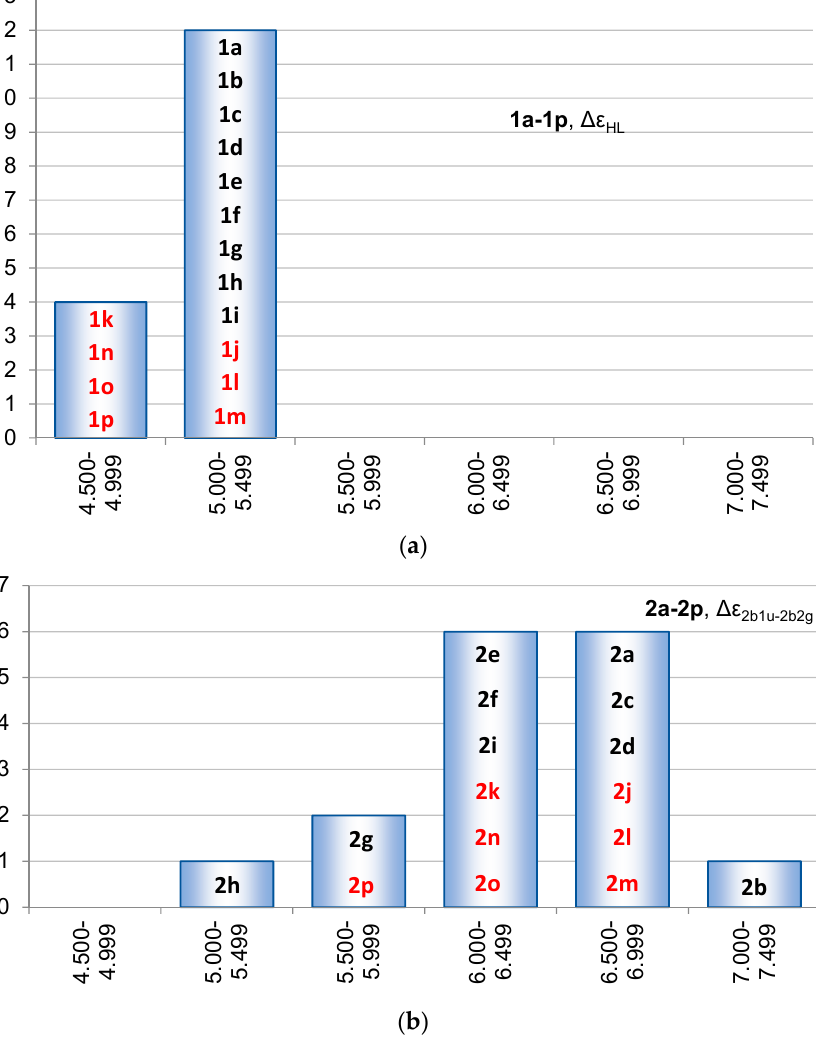
Figure 11. Distribution in ( a ) the HOMO-LUMO energy gaps ( Δε HL ) for 1a – 1p and ( b ) the 2b 1u –2b 2g energy gaps for 2a – 2p (the Δε HL for 2a ). Compound numbers of compounds substituted at the Si atoms in black and those substituted at the C atoms in red.